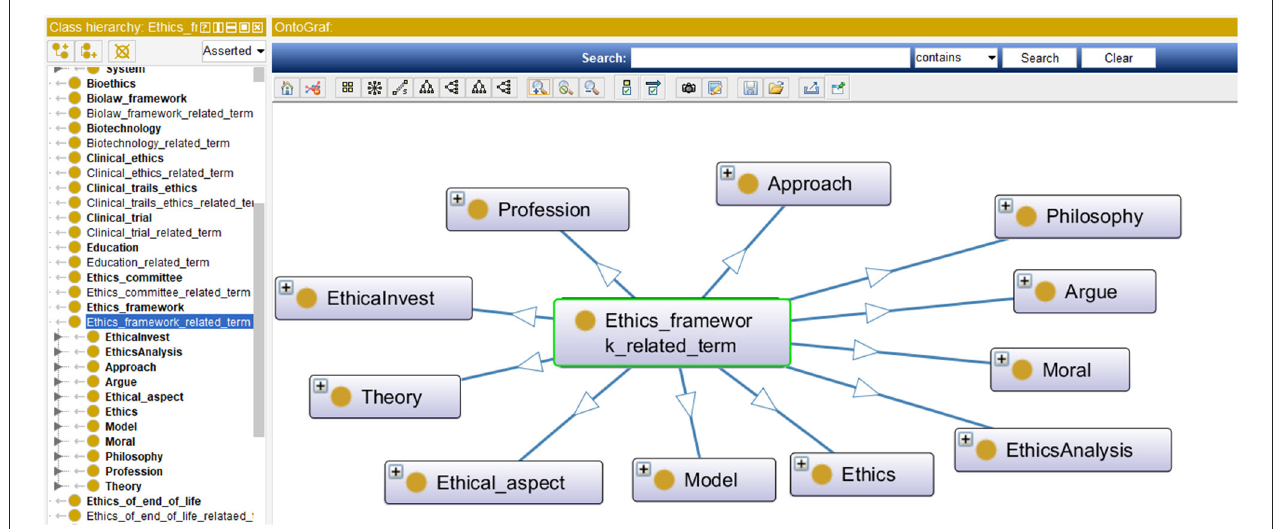
FIGURE 8 | A sample ontological topics from MCB